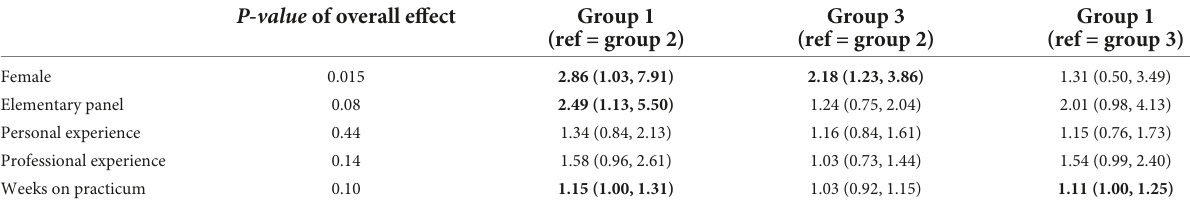
TABLE 4 Odds of belonging to each trajectory group. Odds Ratio (OR) and 95% Confidence intervals are